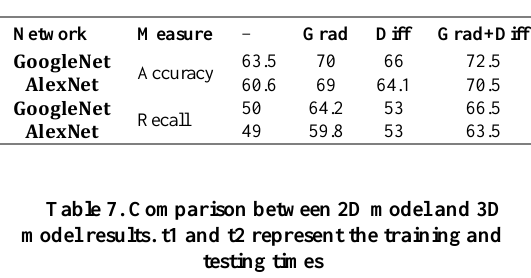
Table 6. Effect of gradient and differentiation layer on VIVA dataset.